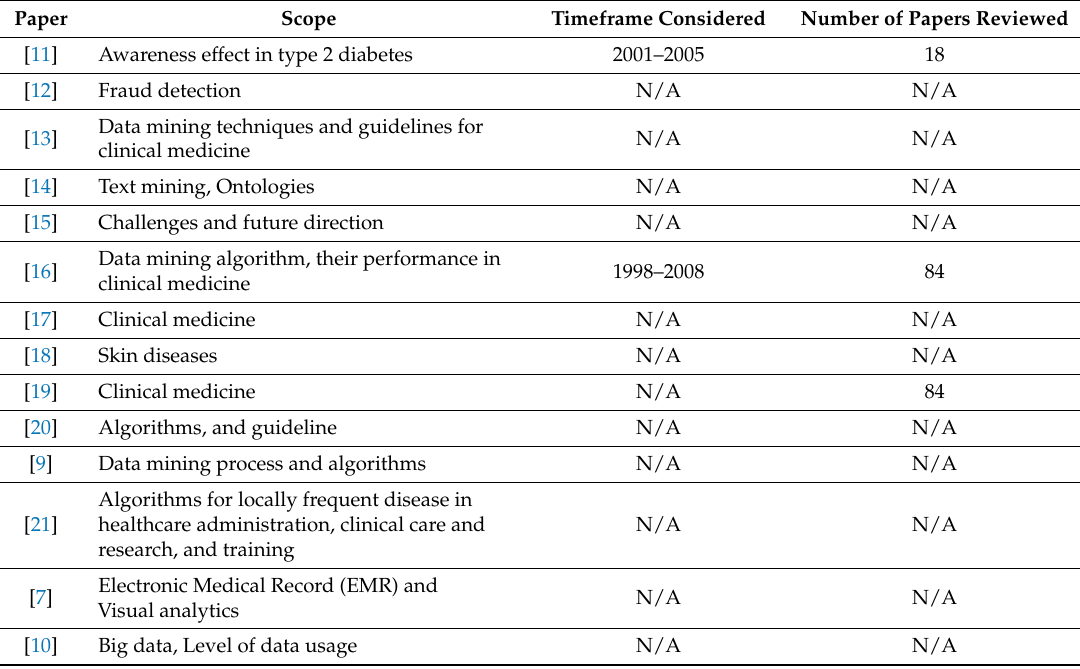
Table 1. Characteristics of existing review/conceptual studies on the related